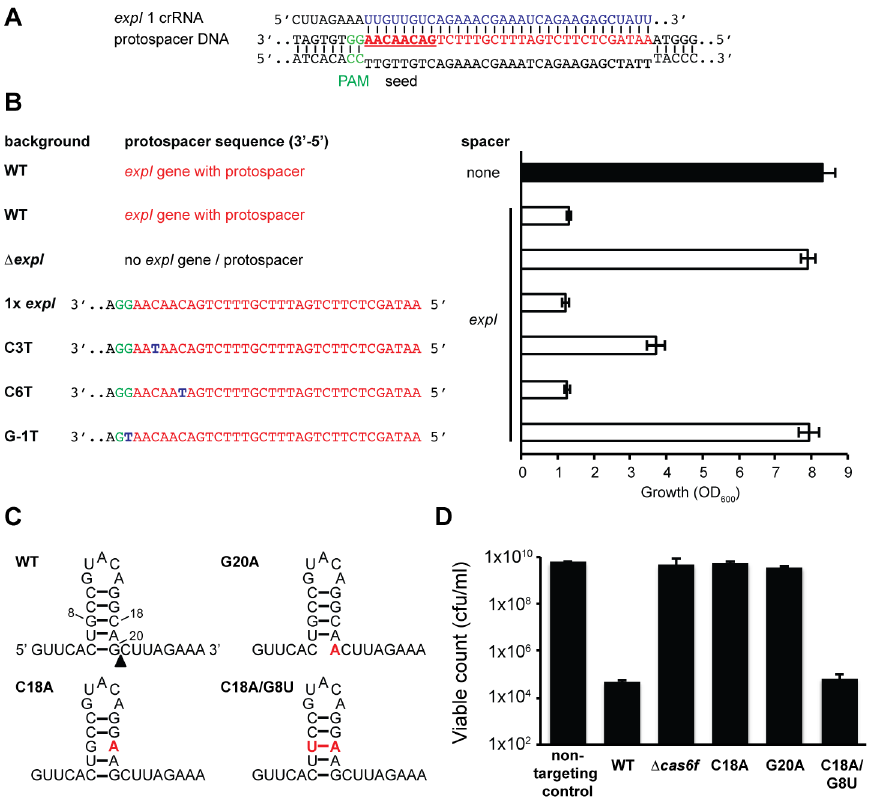
Figure 4. Protospacer, PAM, and repeat mutants can escape toxicity. (A) Predicted pairing between an expI crRNA and the expI protospacer (PAM is green, spacer is blue, protospacer is red and seed sequence is bold and underlined). (B) Left; protospacer sequences in WT, D expI (PCF81), D expI with a single WT (RBV01), C3T (RBV04), C6T (RBV03) or G-1T (PAM) (RBV02) expI protospacer. Right; toxicity assays of a single anti- expI spacer ( expI ; pE1-16; white bars) or a plasmid with no spacers (none; pC1-16; black bar) when expressed in the backgrounds shown on the left. (C) Predicted folds and position of mutations for WT, G20A, C18A and C18A/G8U single CRISPR repeats. The black triangle represents the site of cleavage by Cas6f. (D) Toxicity assays of plasmids expressing a single anti- expI spacer flanked by either WT (pE1-16), G20A (pE1-16 G20A), C18A (pE1-16 C18A) and C18A/ G8U repeats (pE1-16 C18A/G8U) in WT P. atrosepticum .